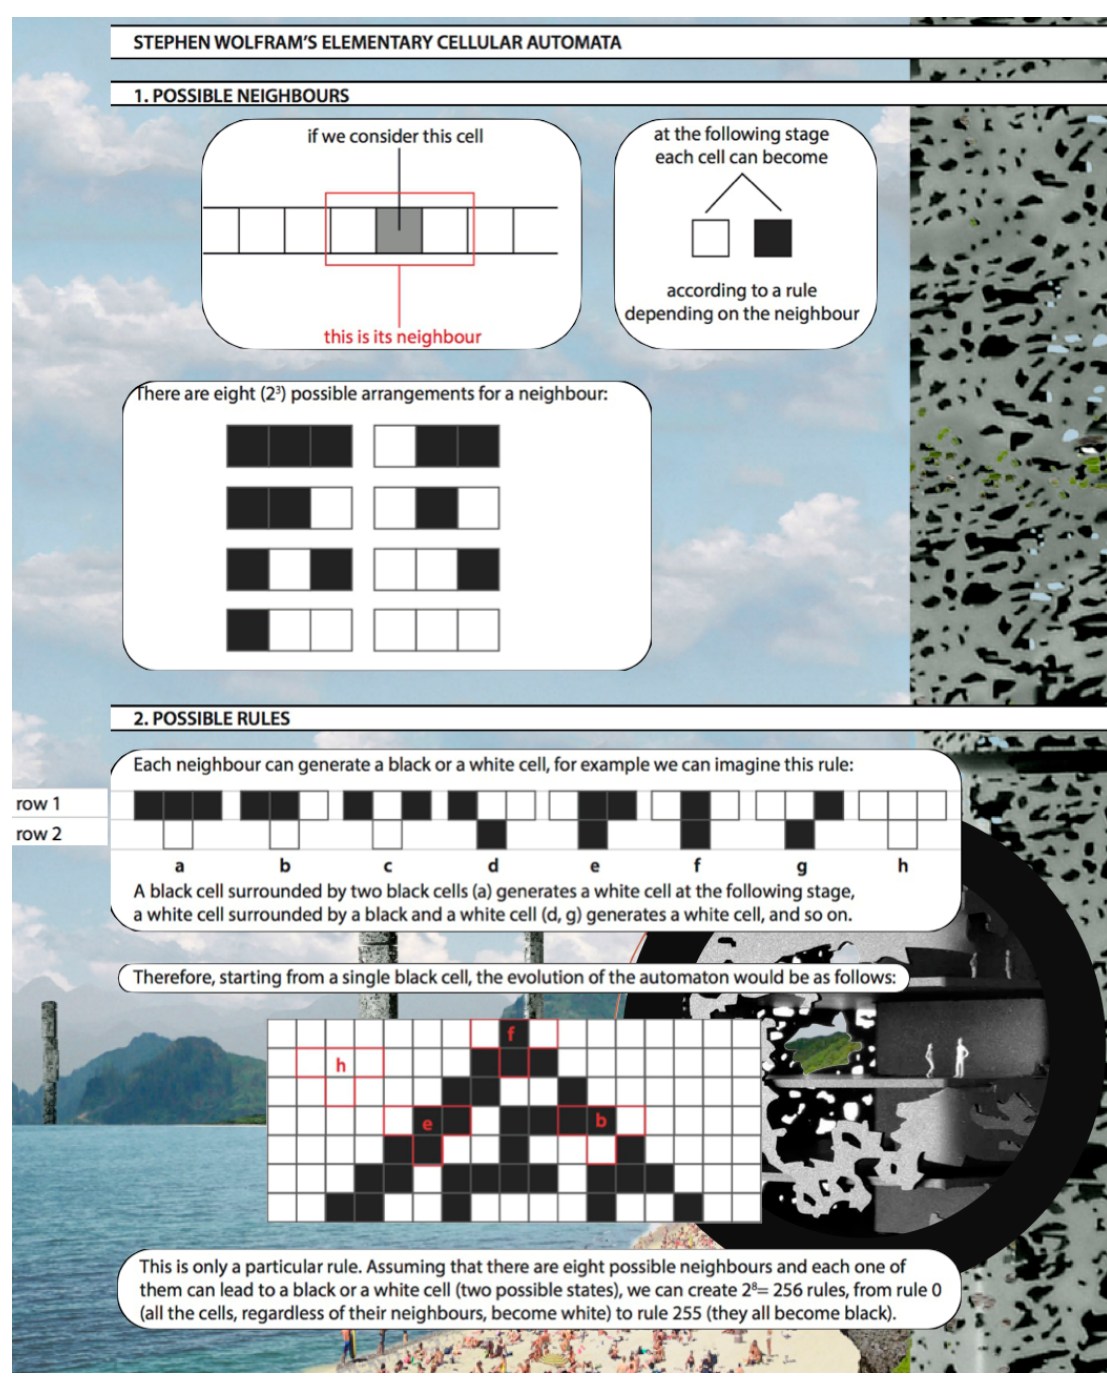
Figure 3. Stephen Wolfram’s elementary cellular automata. In the background, an example of morphogenetic (mimetic)